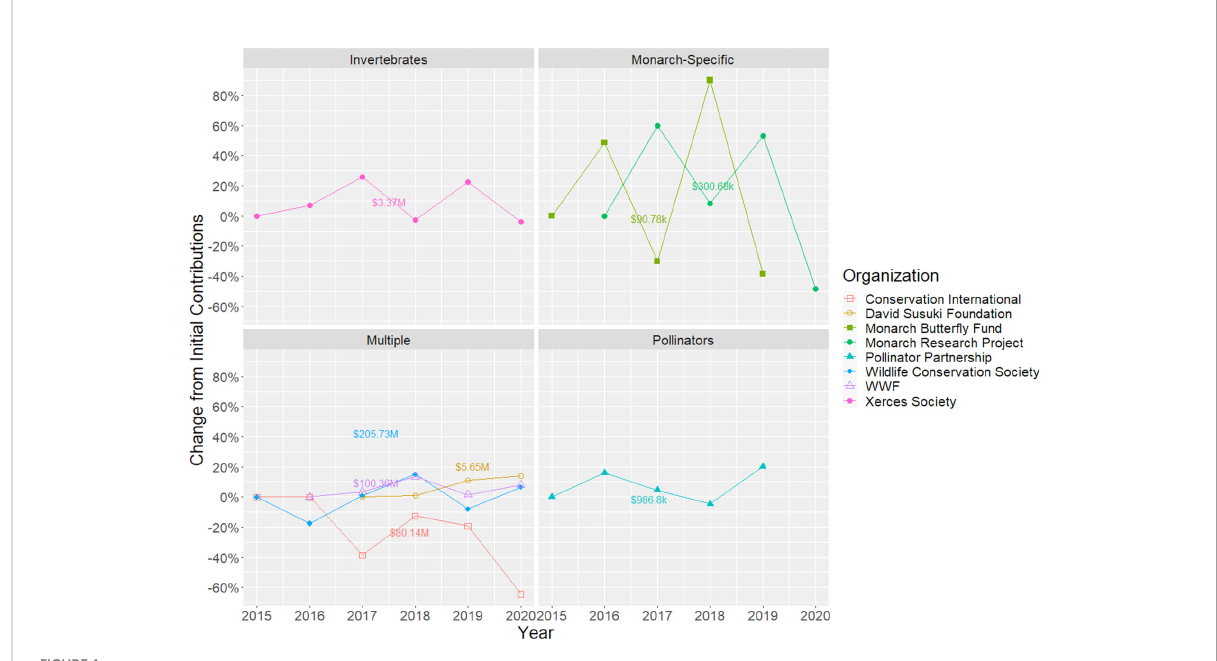
FIGURE 1 Yearly proportional change in revenue from donations for different environmental NGO ’ s. The dollar value on each plot describes the dollar amount on the fi rst data point for each time series. Data of organizations with an open shape represent only donations from private individuals, whereas organizations with a fi lled shape denote total contributions, regardless of donor type. Data sources with open shapes were taken from annual reports (www.propublica.com), whereas closed shapes were obtained from each organization ’ s IRS Return of Organization Exempt from Income Tax Form 990